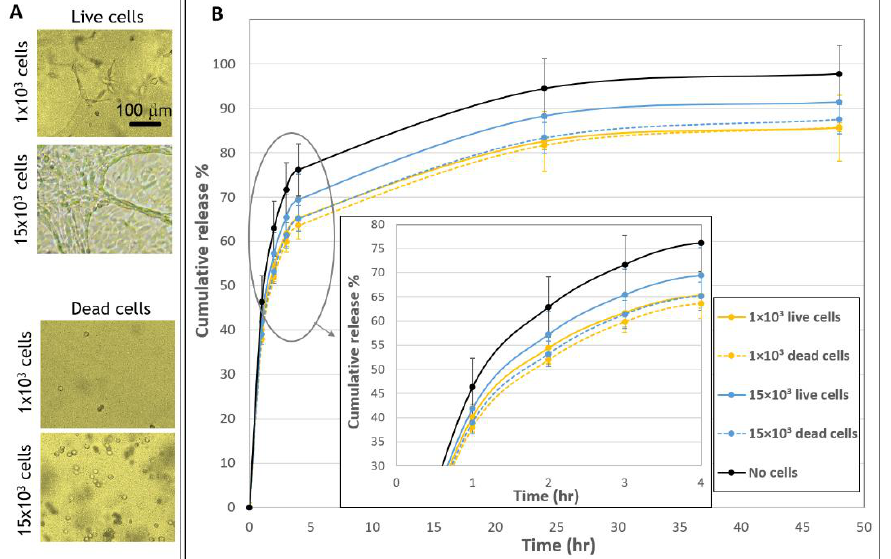
Figure 4. Release profiles from fibrin embedded with live versus dead fibroblast cells. ( A ) Morpholo- gies of live and dead cells 48 h after seeded in fibrin gels. Scale bar is 100 µ m. ( B ) The cumulative release of FD 250 kDa from live and dead cellular samples. Gels were embedded with 1 × 10 3 live cells (yellow, continuous line), 1 × 10 3 dead cells (yellow, dashed line), 15 × 10 3 live cells (blue, continuous line), 15 × 10 3 dead cells (blue, dashed line) or without cells (black, continuous line). A statistically significant difference in release profiles was noted between gels with cells (live/dead) compared to gels without cells . No statistically significant difference was found between gels with 1 × 10 3 dead and live cells and between gels with 1 × 10 3 and 15 × 10 3 dead cells, for all time points. The values represent the mean ± SD of 30 gels for the live samples, 10 gels for the dead samples,